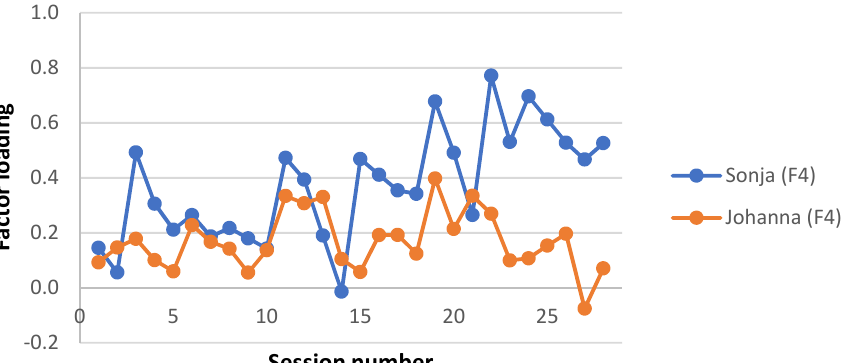
Figure 4. Interaction structure 4: “Fearful but suppressed”. Factor loadings on each session for Sonja